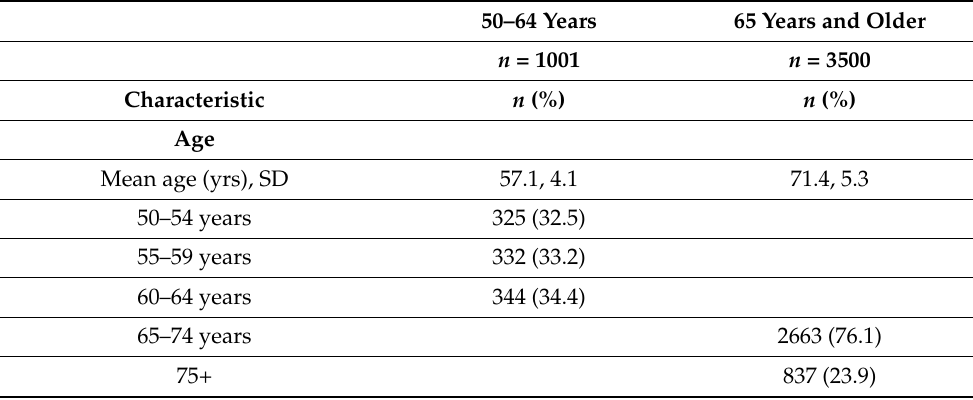
Table 1. Baseline characteristics of